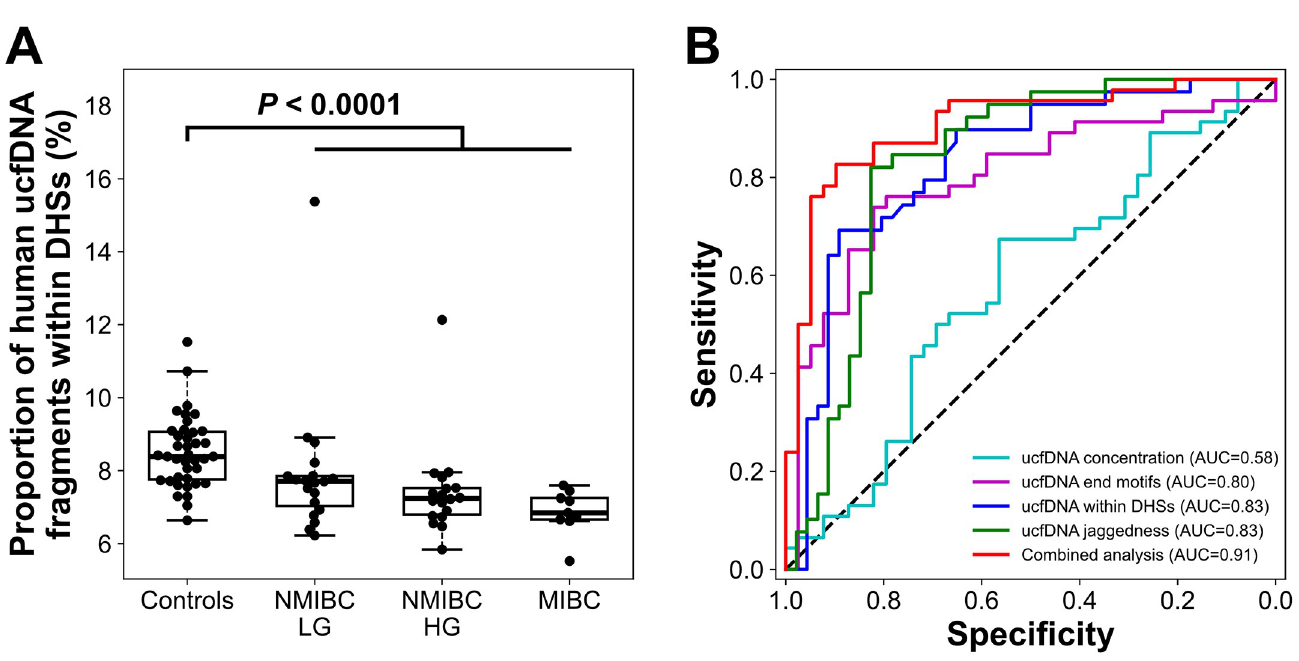
Fig 9. Proportion of human ucfDNA molecules falling within the DHSs. (A) Boxplot showing the proportions of ucfDNA molecules within the DHSs in urine of control subjects with hematuria without bladder cancer (n = 39), and subjects with NMIBC LG (n = 19), NMIBC HG (n = 18), and MIBC (n = 9). (B) ROC plot of differentiation between patients with and without bladder cancer using ucfDNA concentration, jaggedness, end motifs, and the percentage of ucfDNA within DHS.